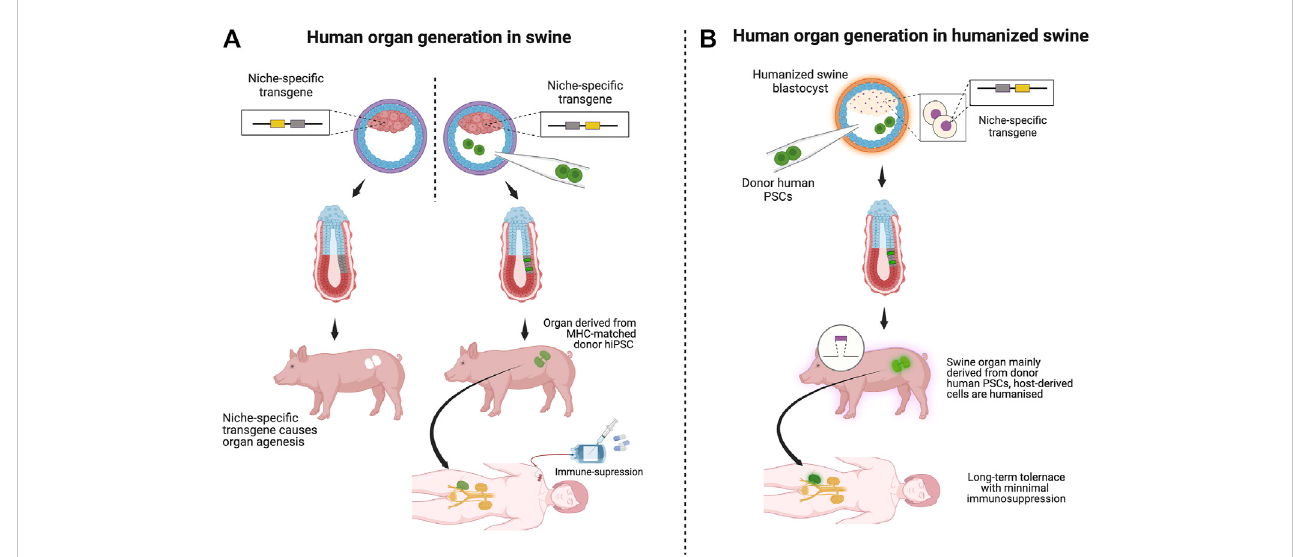
FIGURE 2 Scenarios of organ transplantation derived from various swine models: Schematic: [ (A) , left] In BC, vacant organ niche formation by a niche-speci fi c transgene depletion through genome editing is essential. [ (A) , right] Injection of human patient-derived (or MHC-matched human) iPS cells (green) into a blastocystofahostanimalwithanorganfailurephenotype.[ (A) ,right,and (B) ]. (A) Transplantation ofhumanorgansbyBCisunlikelytofailbecausemostcells are of human origin. Immunosuppression may be necessary if the porcine host origin remains in the graft component. (B) Organs transplanted from human-derivedcellscreatedinhumanizedpigsareassumedtofunctionlong-terminrecipientswithminimalornoimmunosuppressionbecausehumanized pigs are designed to minimize immune rejection. Using humanized swine as host animals for the BC will work as a safety guard system for immune